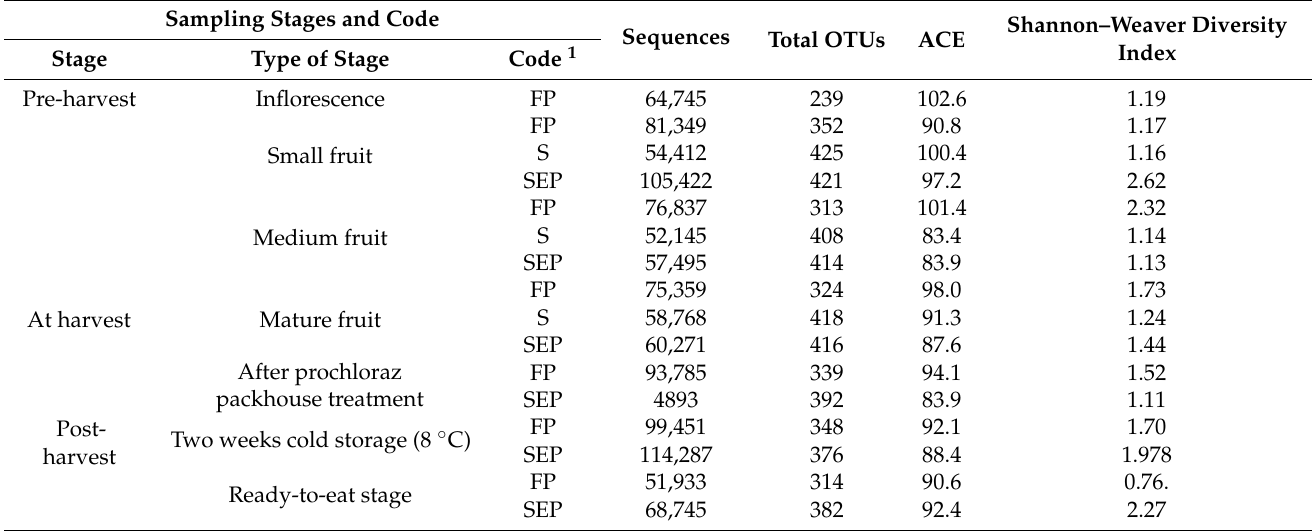
Table 4. Summary of bacterial amplicon sequence counts and diversity estimators for mango inflorescence, fructoplane, fruit stem and stem-end pulp at the pre- and post-harvest stages of cv. Tommy Atkins